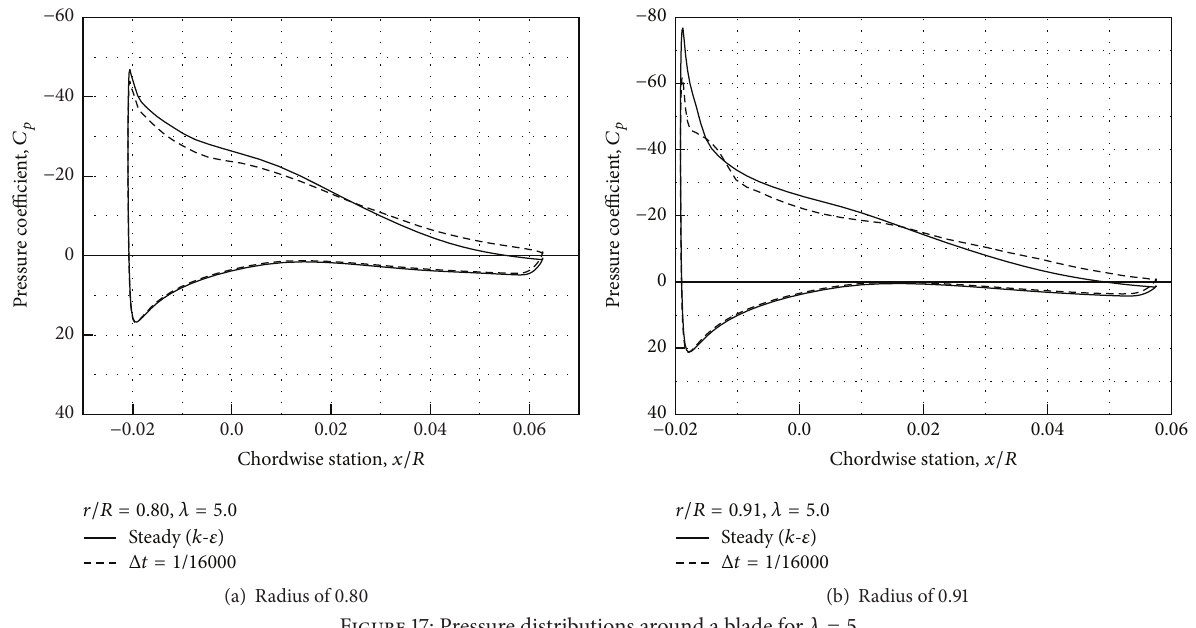
Figure 17: Pressure distributions around a blade for 𝜆 = 5